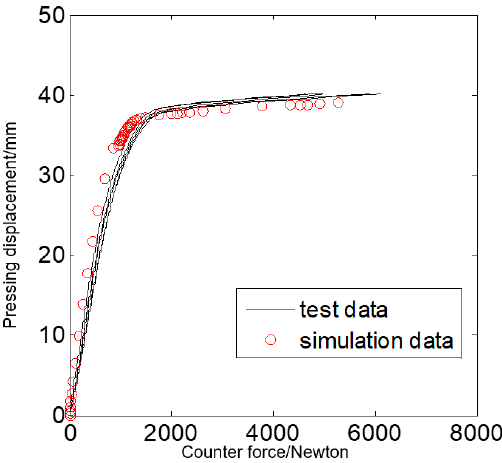
Figure 12. Comparison of the counter force tests results and the simulation results.